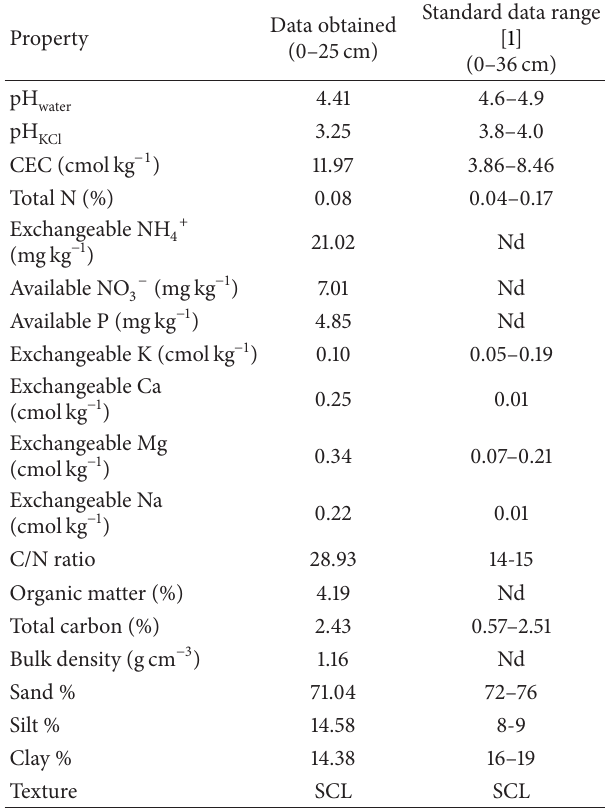
Table 1: Selected chemical and physical properties of Bekenu series.